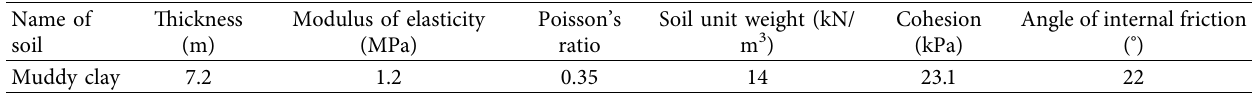
Table 3: Muddy clay parameters [25].